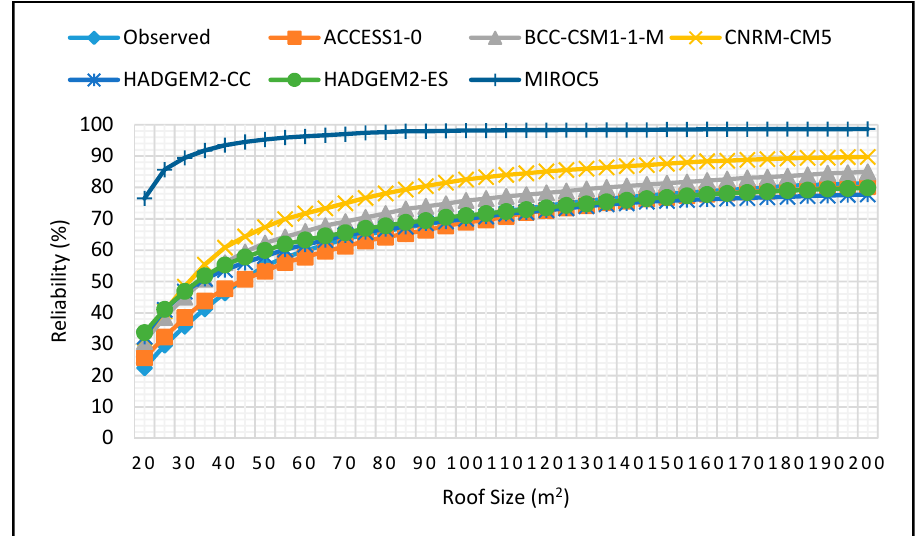
Figure 22. Reliability projections for JJA season for 2 m 3 tank size for 2060–2090 period.